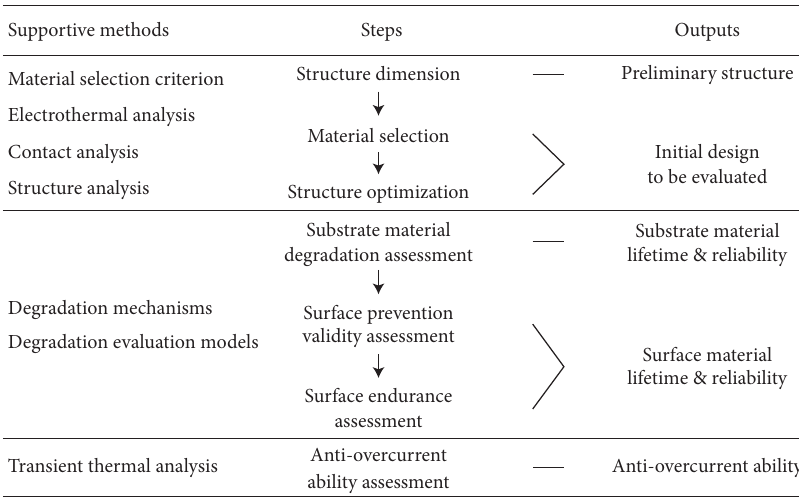
Figure 1: The framework of the reliability evaluation